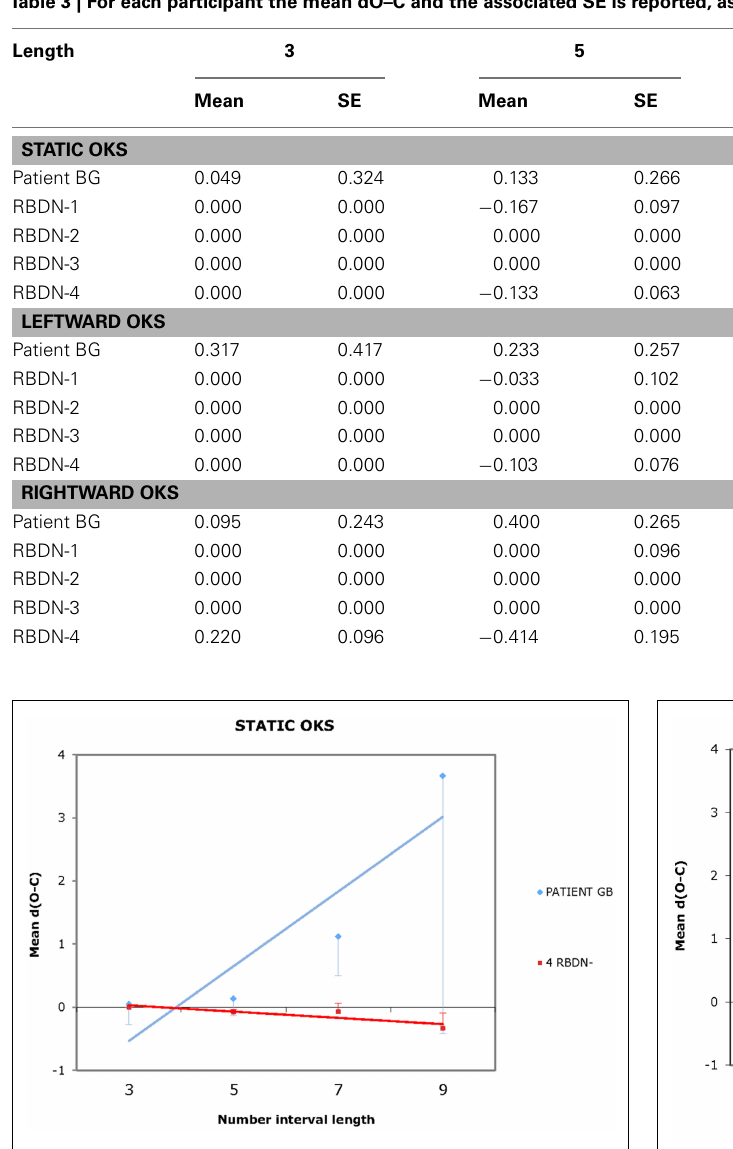
Table 3 | For each participant the mean dO–C and the associated SE is reported, as a function of number interval length and OKS.